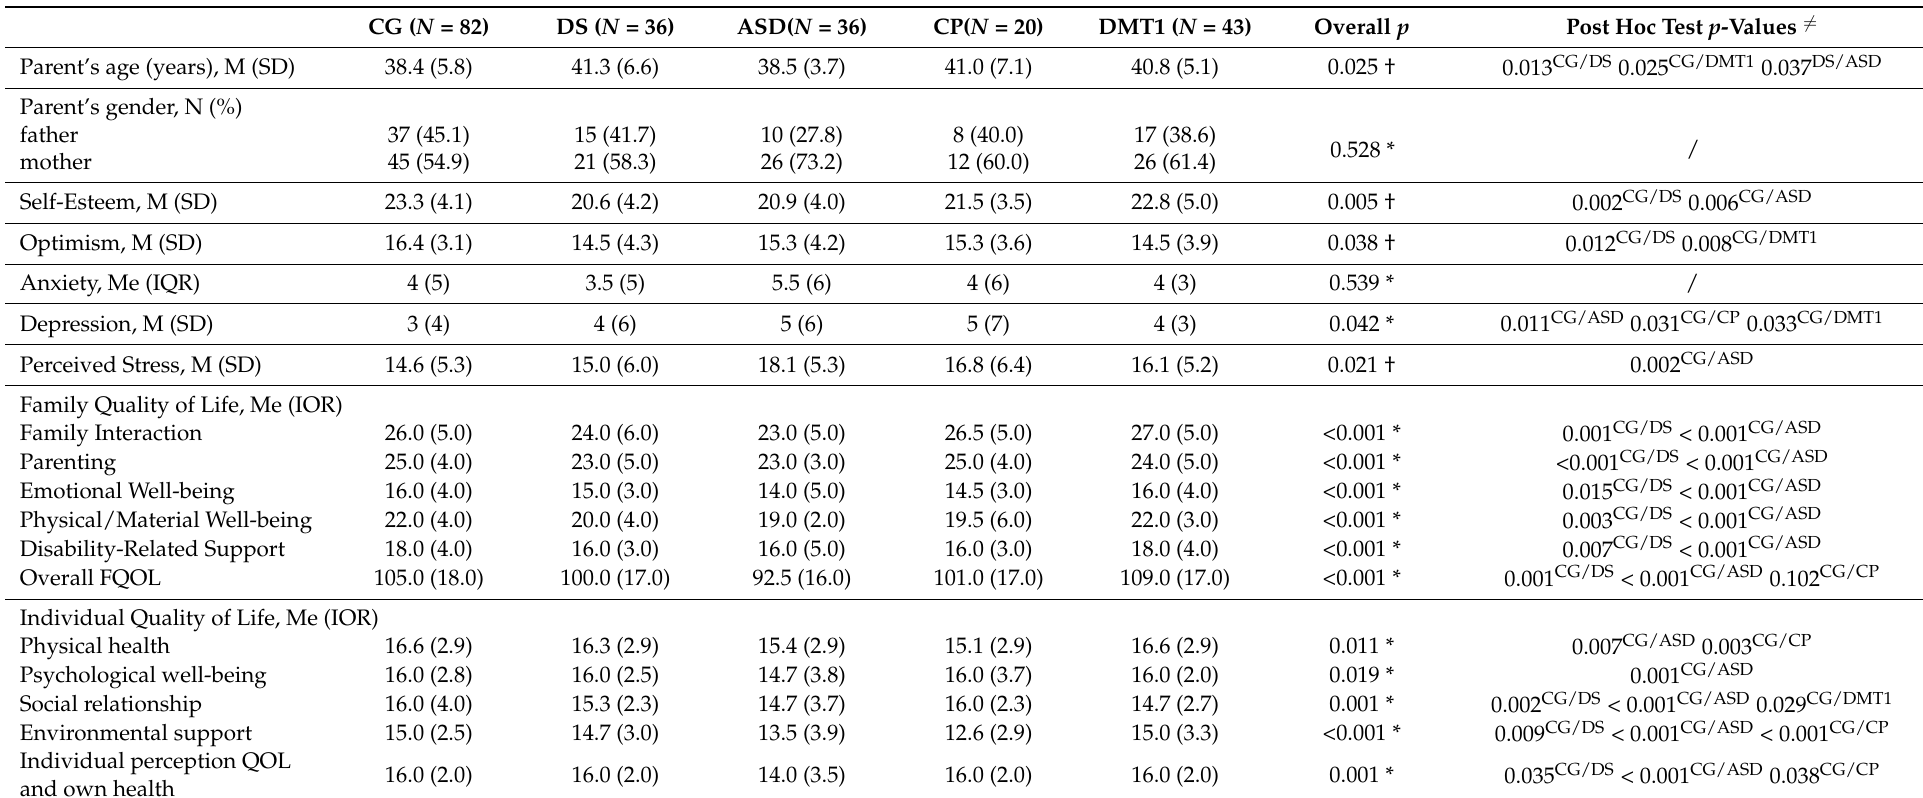
Table 1. Quality of life and psychological characteristics according to study